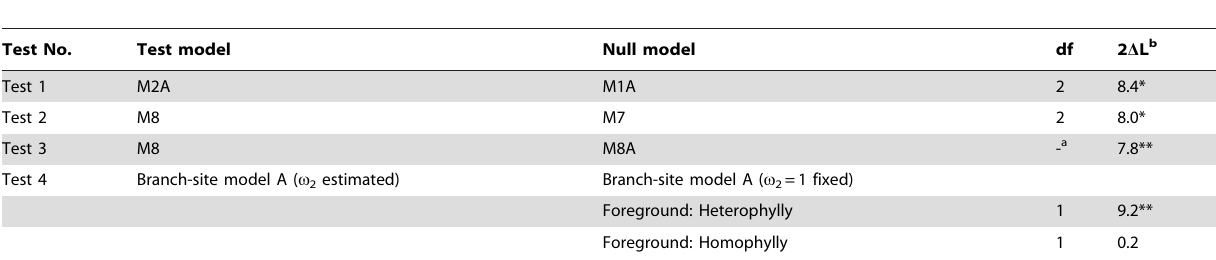
Table 2. LRT statistics for testing the hypothesis of positive selection in Potamogeton rbcL .